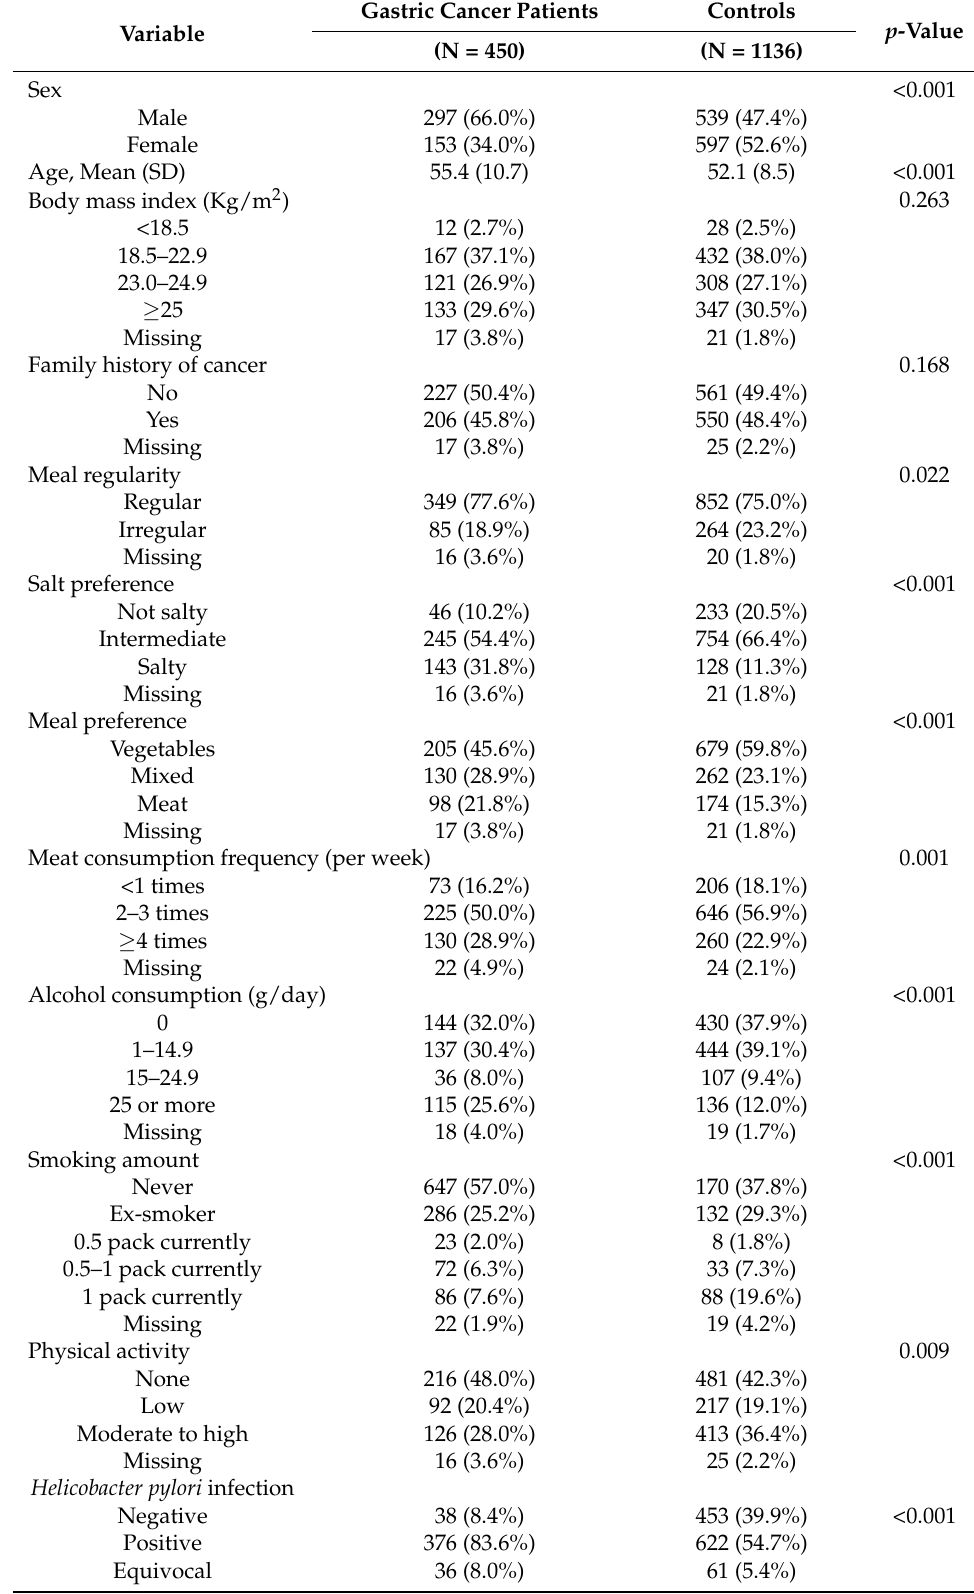
Table 1. Basic characteristics of the study